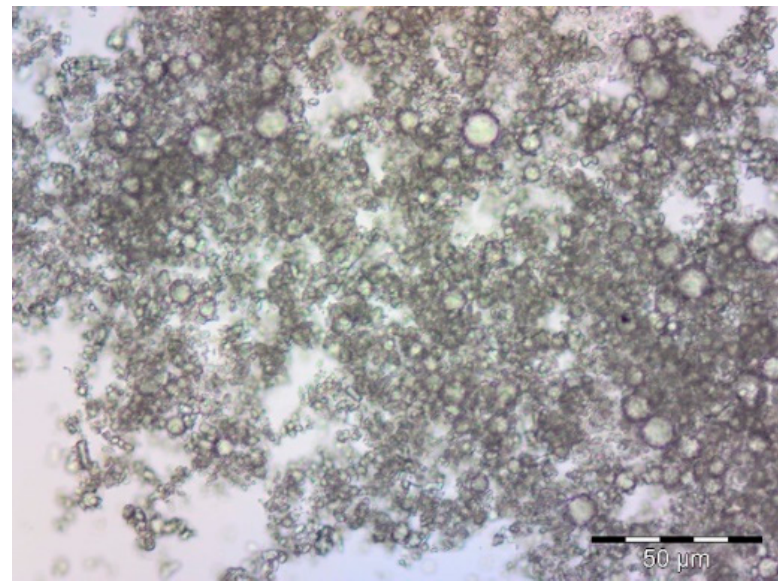
Figure 7. Optical microscopy image of complex. Magnification 500×.